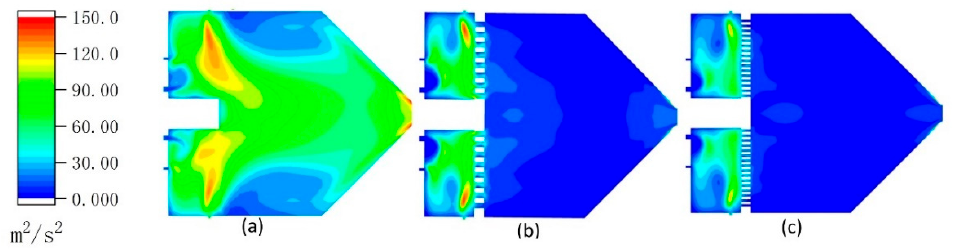
Figure 7. Contours of turbulent kinetic energy inside the spray gun: ( a ) second meshes, ( b ) third meshes, and ( c ) fourth meshes.